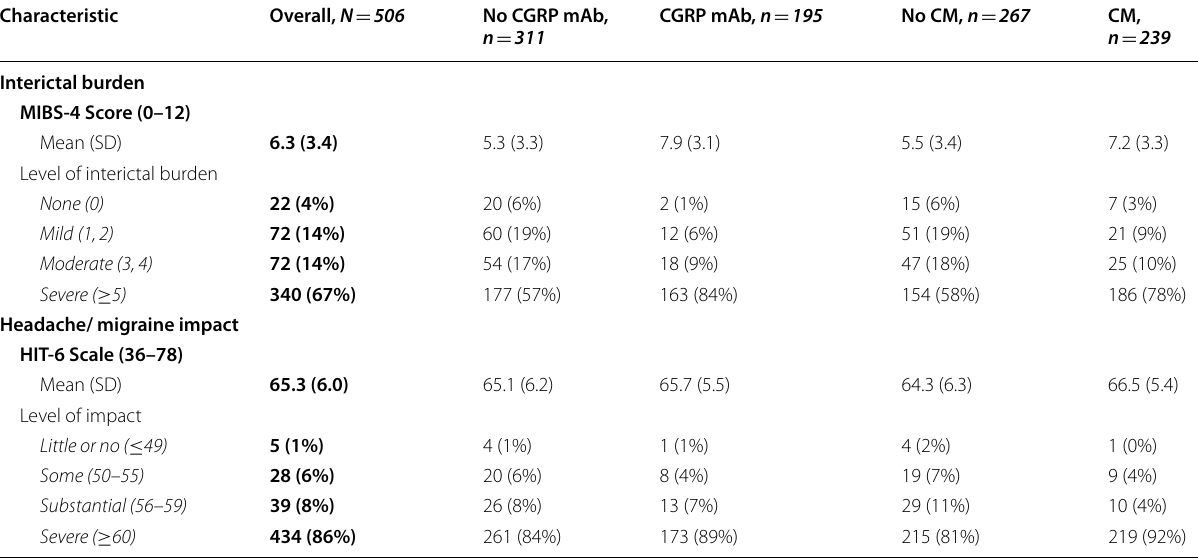
Table 2 Migraine Interictal Burden Scale (MIBS-4) and Headache Impact Test (HIT-6) overall and stratified by CGRP mAb treatment experience (3 months) and chronic migraine (CM) diagnosis +